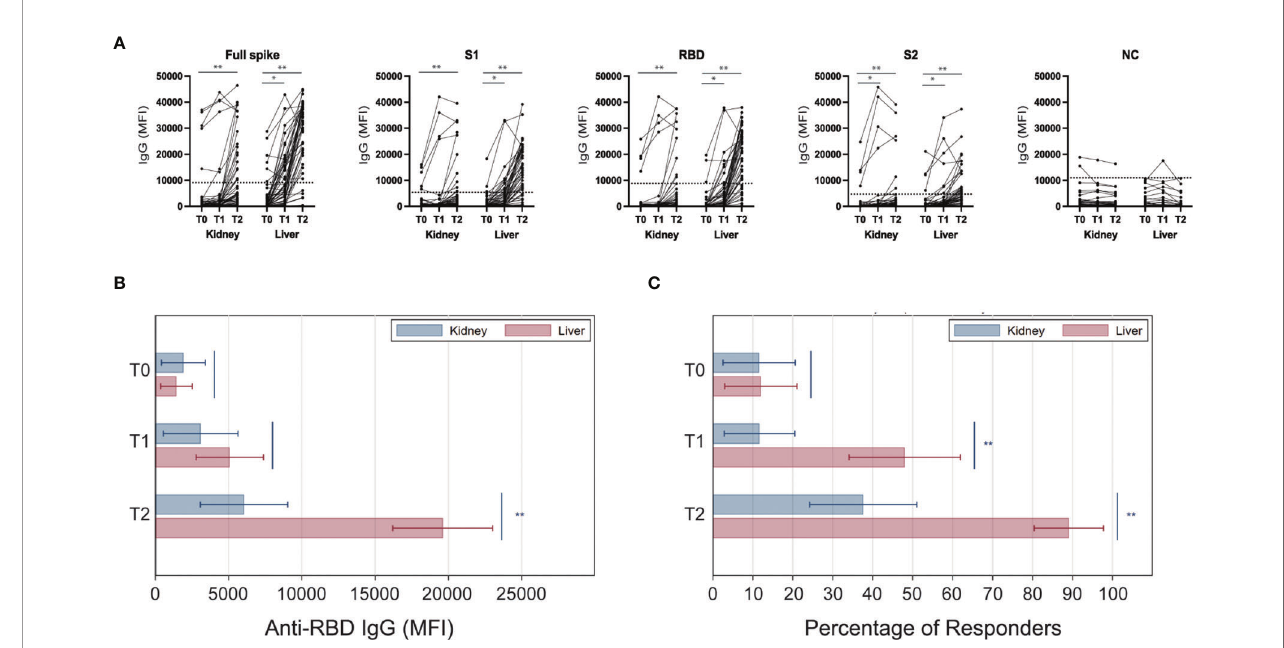
FIGURE 2 | Anti-viral IgG levels in kidney and liver transplant recipients after SARS-CoV-2 vaccination. Serum samples were collected at the time of the fi rst (T0) and the second (T1) mRNA SARS-CoV-2 vaccine administration, and at 3 weeks after the second dose (T2). (A) Serological response of individual subjects against each of the tested viral antigens. Level considered positive is indicated by dotted horizontal lines for each antibody speci fi city. (B) Levels of IgG anti-RBD in kidney (blue) and liver (red) kidney transplant recipients at each time point. (C) Analyses shown in panel B were repeated after stratifying patients based on anti-RBD antibody response (MFI threshold for positivity: 8880). Horizontal lines represent 95 percent con fi dence intervals. *P < 0.05, **P < 0.01. MFI, Mean Fluorescence